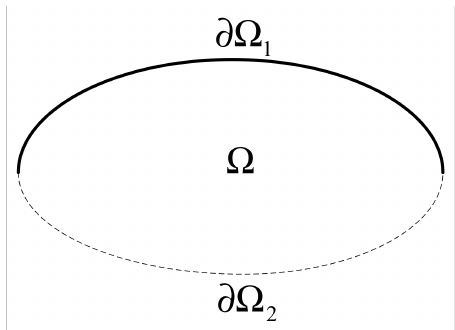
Figure 1. Illustration of the inverse heat conduction problem in two dimensions.